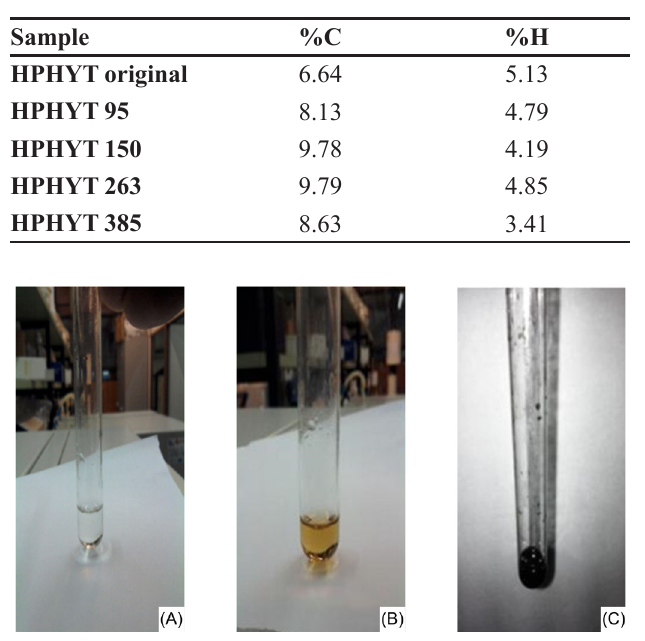
FIGURE 4 - Pictures of phytic acid samples: (A) original; (B) held at 150 °C for 1 h; (C) held at 150 °C for 24